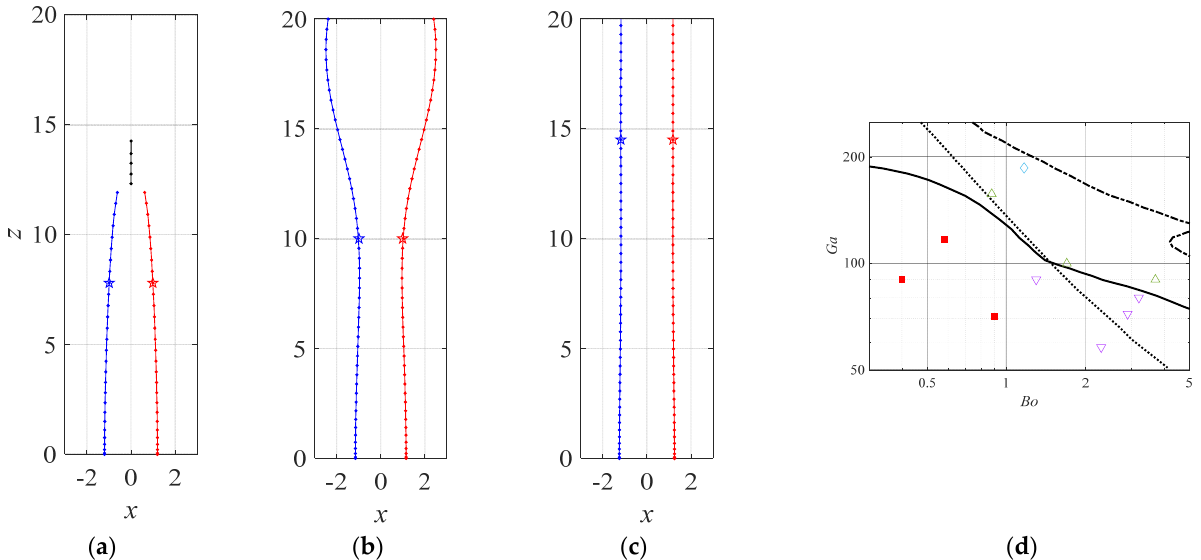
Figure 7. Trajectories of pair of bubbles ( a – c ), phase diagram of single bubble behavior (Cano–Lozano et al., 2016), and a pair of bubbles’ behavior in ( Ga , Bo ) plane ( d ). ( a ) Case 2N; ( b ) case 4N; ( c ) case 6N; symbols: ⋆ : typical time in Figures 8–10; ( d ) ■ : M1/M2; △ : M3; ♢ : M4; ▽ : M5. Table 4. Trajectories of a pair of bubbles and conditions in the numerical simulation.